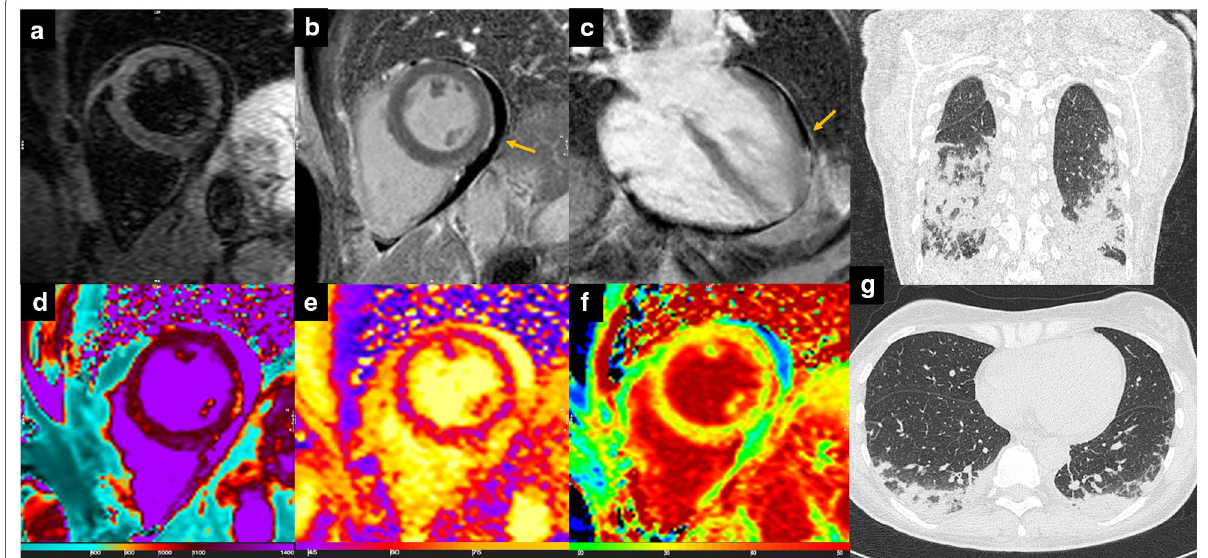
Fig. 4 Pericarditis. 36-year-old in-hospital COVID-19 patient with chest discomfort and evidence of pericardial effusion at bedside Echo. a Evidence a slight hyperintensity of the pericardial layers, with no myocardial edema. LGE sequences confirm the presence on pericardial layers enhancement and moderate pericardial effusion ( b , c orange arrows). Native T1 values were mildly increased ( d ) as well as T2 mapping ( e ) and ECV values ( f ). Coronal and axial chest CT revealed peripheral posterior areas of parenchymal consolidation ( g ). Echo echocardiography; STIR short tau inversion recovery; LGE late gadolinium enhancement; ECV extracellular volume; CT computed